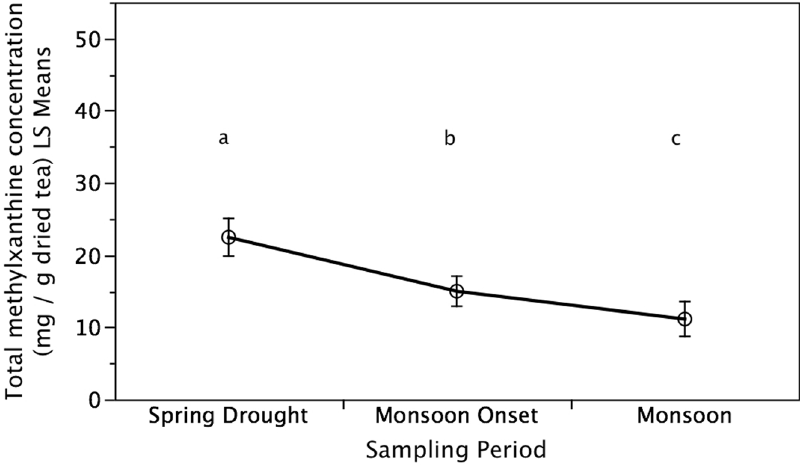
Figure 4. Effects of Precipitation Variability on Total Methylxanthine Concentration. Increased precipitation from the spring drought to the monsoon tea harvest resulted in significantly lower total methylxanthine concentration (TMC) of tea leaves. Sampling periods not connected by the same letters are significantly different. Values are means 6 one standard error.